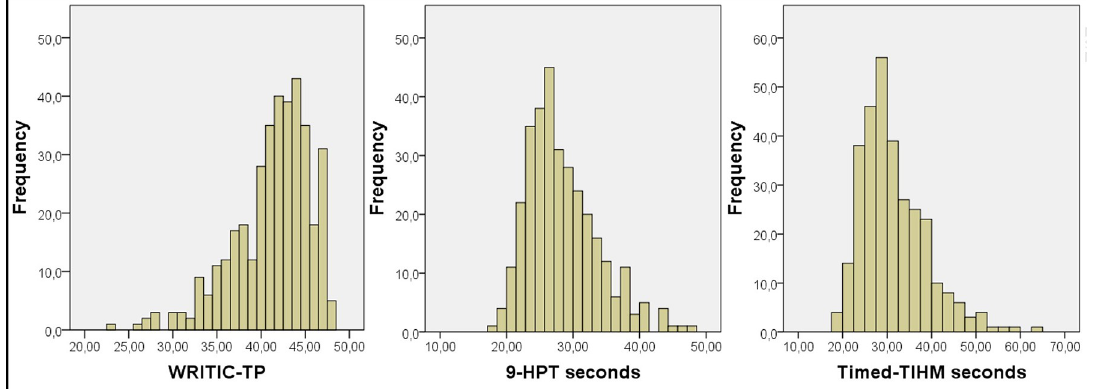
Fig 1. Frequency of points on (A) ‘Task performance’ of the Writing Readiness Inventory Tool In Context (WRITIC-TP), (B) seconds on Nine-Hole Peg Test (9-HPT) and (C) the Timed Test of In-Hand Manipulation (Timed-TIHM). WRITIC-TP is negatively skewed, 9-HPT and Timed-TIHM